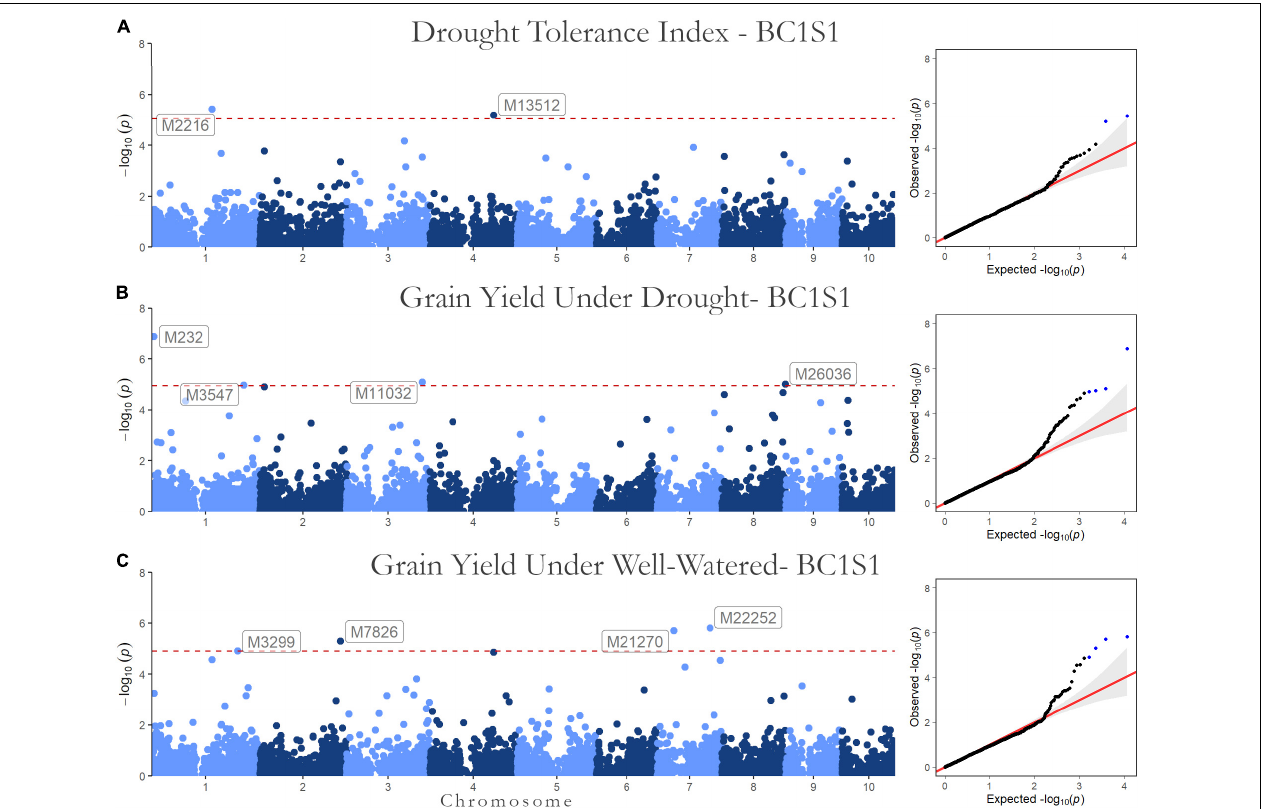
FIGURE 3 | Genome-wide Association results for the first generation (BC1S1-TC1). Manhattan plot and QQ-plots for the (A) drought tolerance index, grain yield in (B) drought, and (C) well-watered